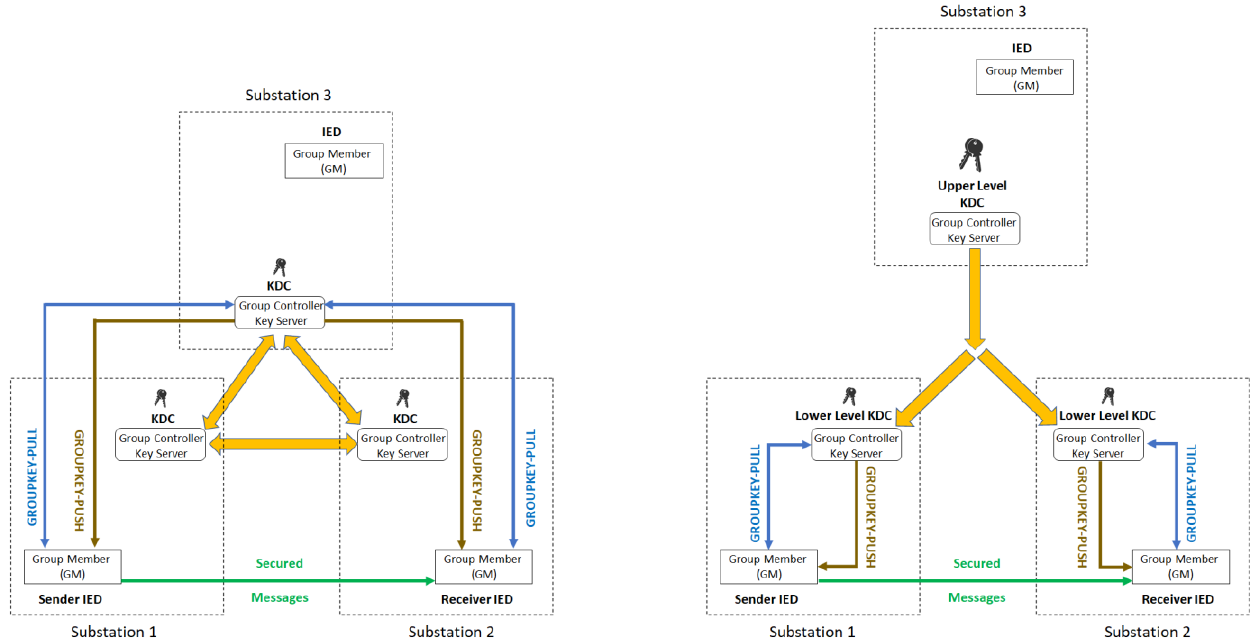
Figure 9. Decentralized security architectures: Fully Connected ( left ) and Hierarchical ( right ).